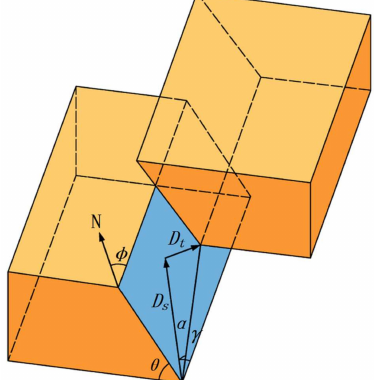
Figure 4. Schematic diagram of a general dislocation model for source rupture [59]. N represents the north direction; D t and D s represent the shear and vertical displacement vector, respectively; φ , θ , and γ represent the strike, dip, and slip angle, respectively; α represents the dislocation angle. In this fault model, the initial fault gap is not taken into